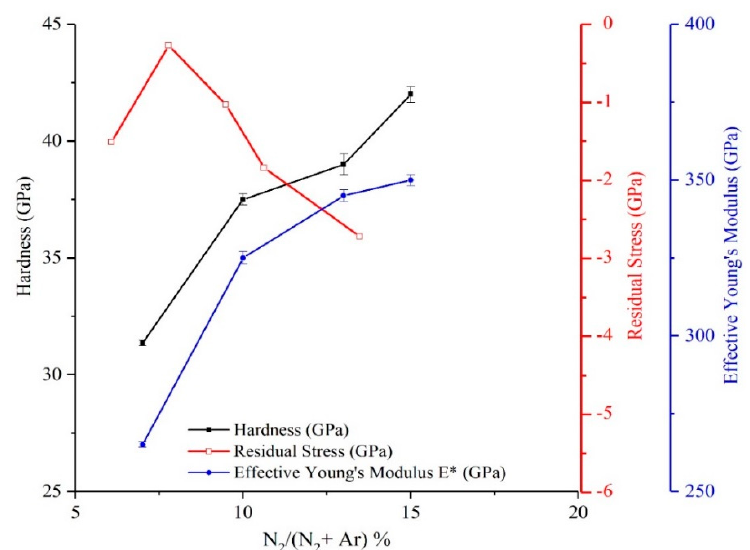
Figure 8. Variation in hardness, Young’s modulus and residual stress for the films deposited with N 2 varying from 7% to 15%.